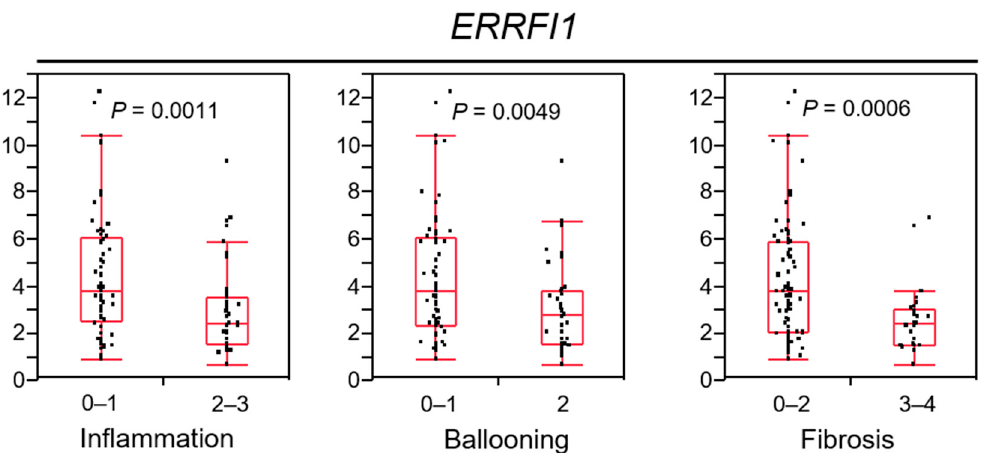
Figure 7. ERBB receptor feedback inhibitor 1 ( ERRFI1 ) expression decreases in parallel with non-alcoholic steatohepatitis (NASH) progression.